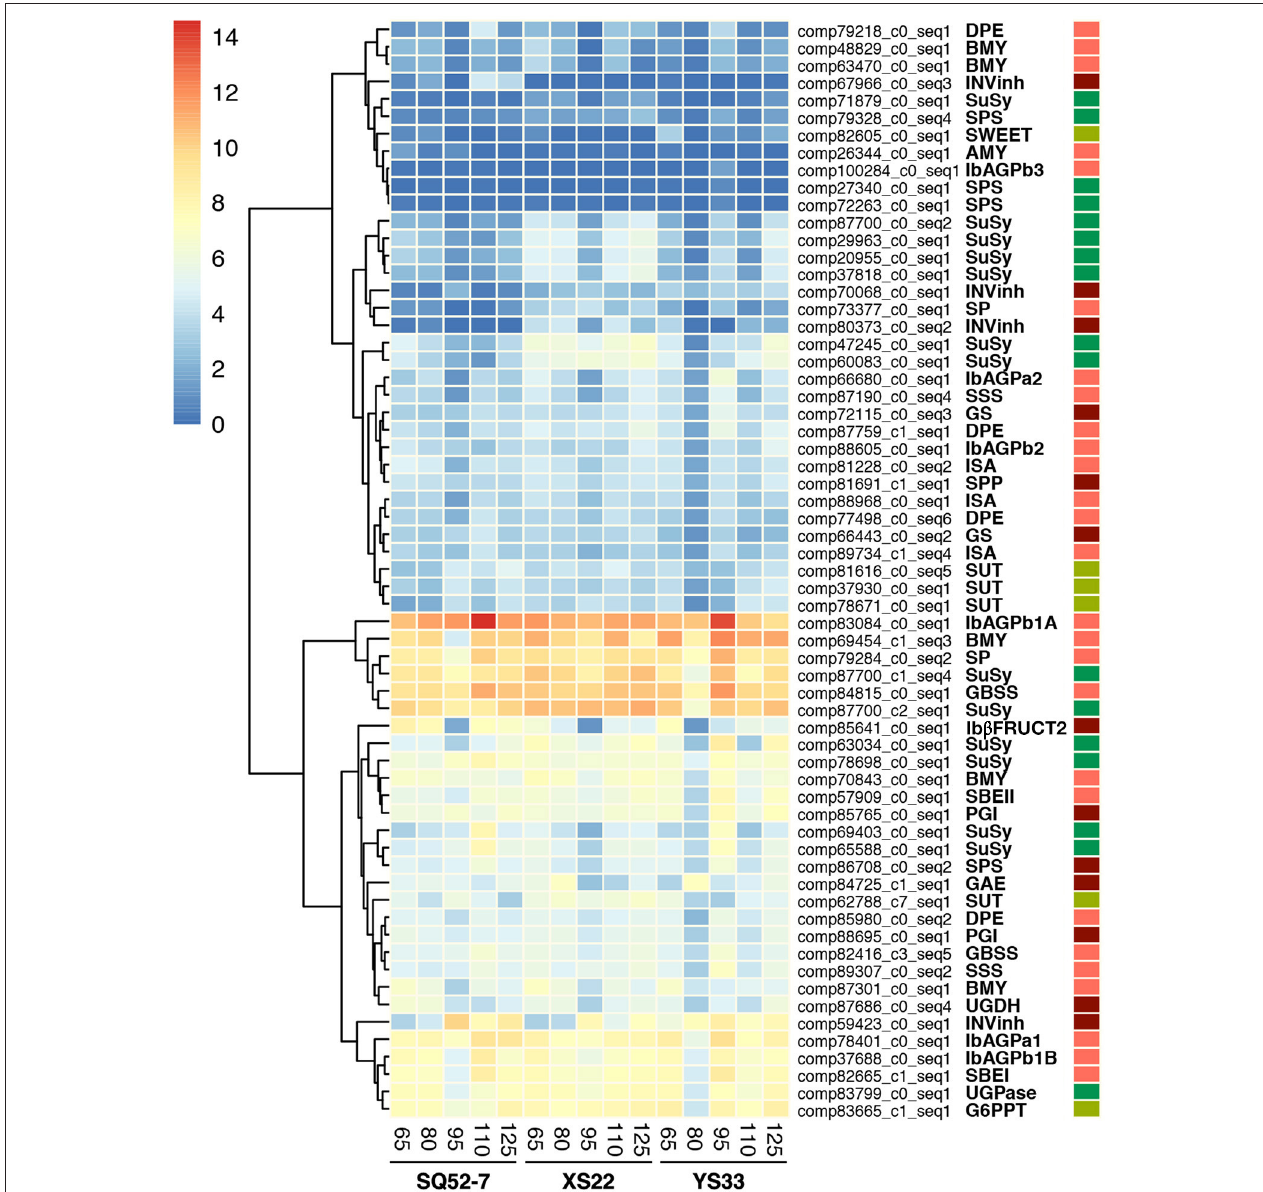
FIGURE 6 | Expression patterns of unigenes encoding enzymes involved in starch and sucrose metabolism during SR development in three sweet potato genotypes. Cluster analysis was performed to group DEGs with similar expression levels and patterns based on the normalized log2-transformed RPKM values of DEGs. The abbreviations of enzymes and transporters encoded by DEGs are shown in Figure S2. GS, glycogen (starch) synthase (EC 2.4.1.11); IbAGPa1, IbAGPa2, IbAGPb1A, IbAGPb1B, IbAGPb2, ADP-glucose pyrophosphorylase (AGPase, EC 2.7.7.27) small subunit 1, 2, and large subunit 1, 2, and 3, respectively; Ib β FRUCT2, β -fructofuranosidase (EC 3.2.1.26); INVInh, invertase inhibitor; SBEI and SBEII, class I and II starch branching enzyme (EC 2.4.1.18), respectively. Red, dark red, green, and pale green rectangles on the right side indicate DEGs involved in starch granule formation and degradation, sucrose metabolism, sucrose synthesis and conversion, and DEGs encoding transporters,